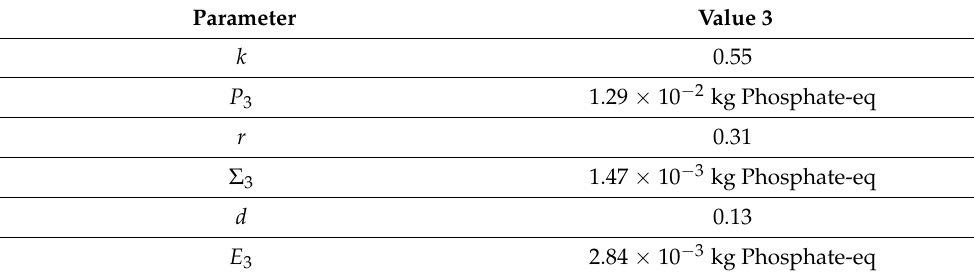
Table 3. Parameter values of the eutrophication potential.